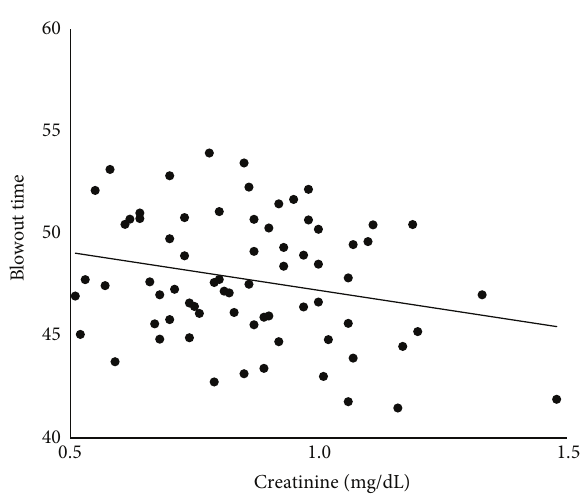
Figure 3: Correlation between blowout time and estimated glomerular filtration rate (GFR) in all subjects.